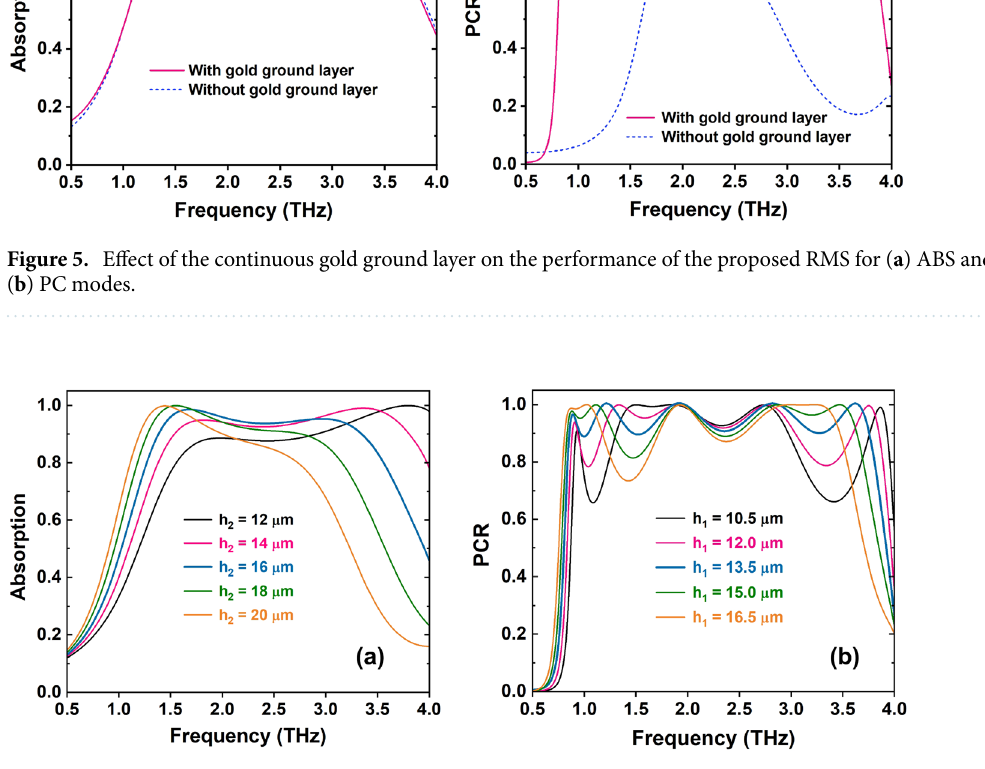
Figure 6. Dependence of the proposed RMS performance on the thickness of dielectric layers: ( a ) h 2 and ( b ) h 1